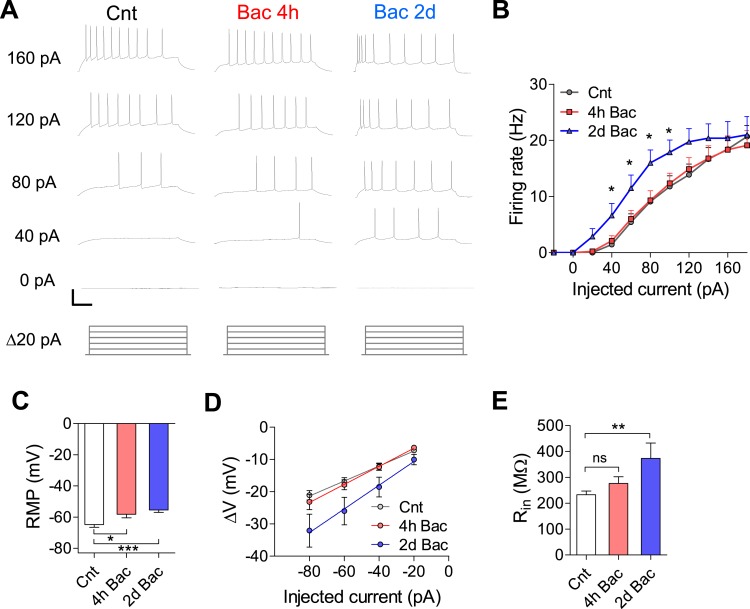
Intrinsic excitability is increased in response to activity suppression.(A) Representative traces of voltage responses evoked by 20 pA step of current injections after control, 4 hr and 2 days baclofen incubation, elicited from RMP (scale bars: 40 mV, 100 ms). (B) F–I relationship after control, 4 hr and 2 days baclofen incubation. After 2 days incubation there is a significant leftward shift of the curve showing greater excitability (control, n = 18; 4 hr, n = 18; 2 days, n = 16; *p < 0.05) following long-term GABABR activation. (C) RMP is depolarized after short baclofen incubation (control, n = 19; 4 hr, n = 21; 2 days, n = 14). (D) I–V curve (same cells as C). (E) Rin is significantly increased following 2 day baclofen incubation (same cells as C).